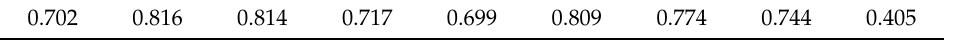
Table 4. Values of correlation coefficients (maximum relevance: Features vs. class), WBC data.